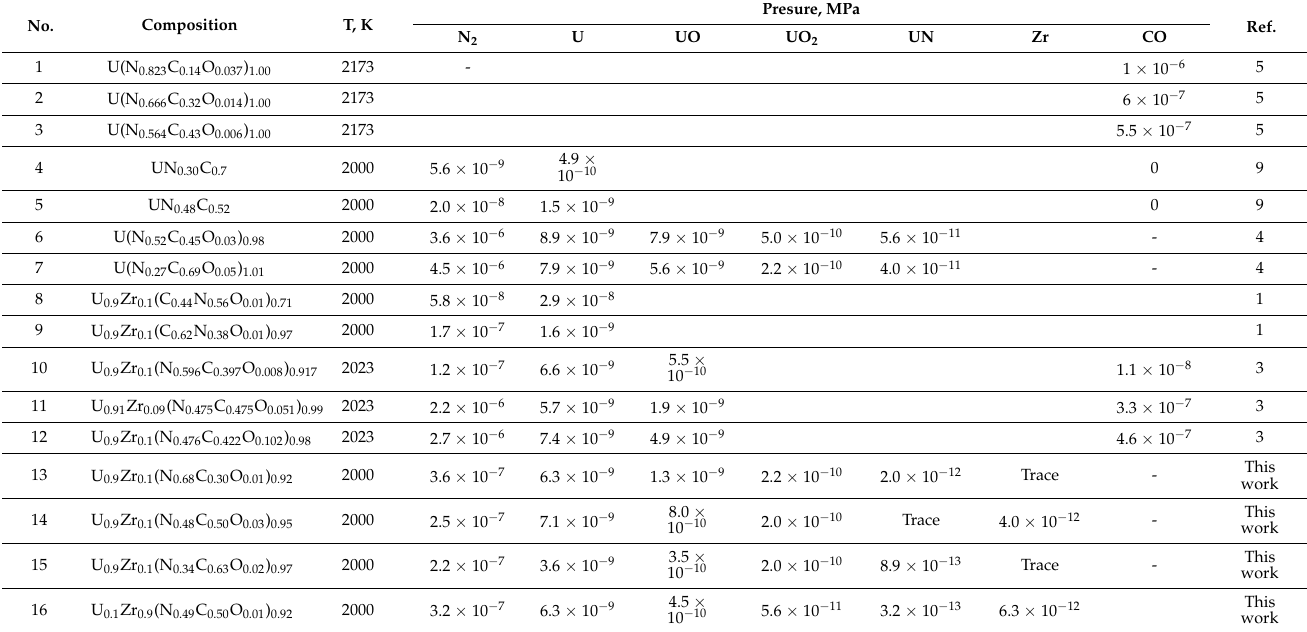
Table 5. Composition and equilibrium pressures of components over UCN and UZrCN with different contents of carbon, nitrogen, and oxygen impurities at high temperatures according to different